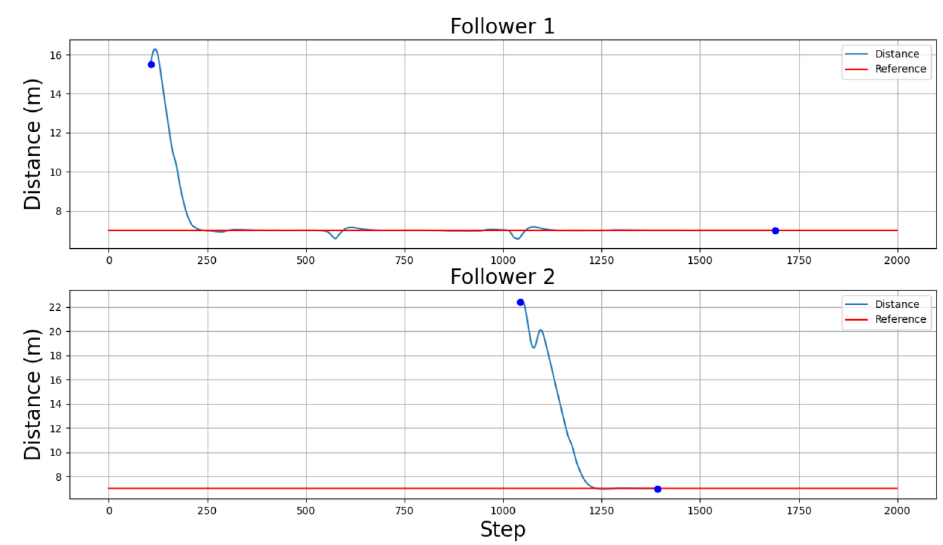
Figure 15. Followers’ distance to their predecessors along the simulation, but only represented during the platoon-following state time stamps.